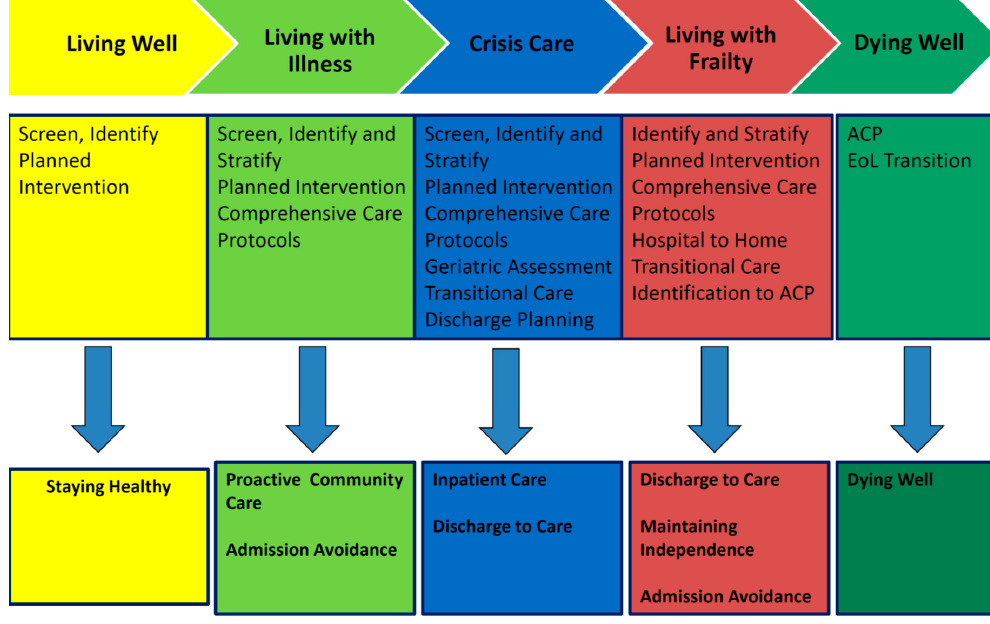
Figure 2. The National Health Group (NHG) blueprint across the care continuum. EoL: end ‐ of ‐ life.